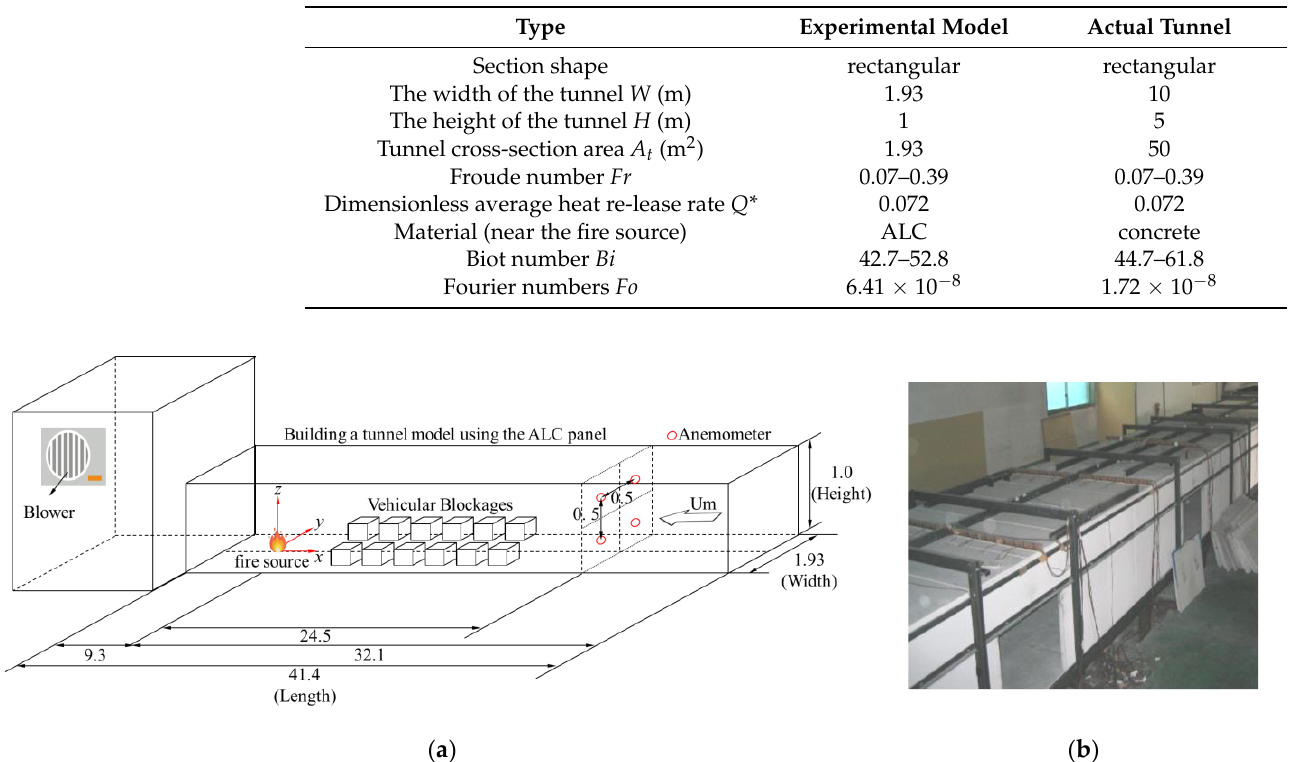
Table 2. List of model tunnels and actual tunnels.